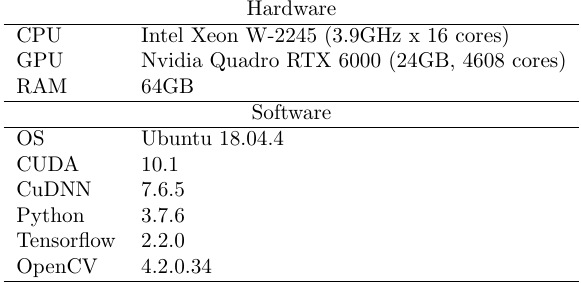
Table 2: Hardware and software used for this